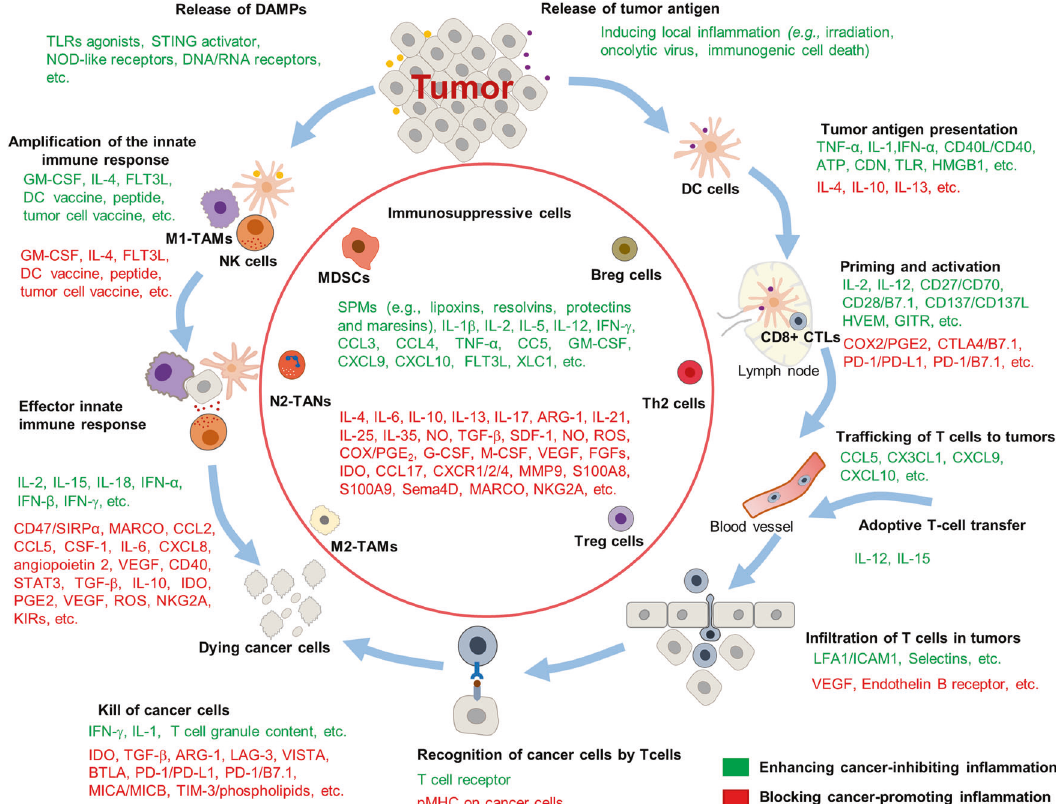
Fig. 4 Harnessing the in fl ammation in cancer therapy. Several promising strategies for regulation of cancer-related in fl ammation have been suggested to improve anti-tumor response. On the one hand, inducing in fl ammation and modulating immune cell activation would overcome T-cell exclusion, turning “ cold ” tumors into “ hot ” tumors, for instance, local in fl ammation induced by irradiation or oncolytic viruses can promote innate immunity by activating nucleic-acid-sensing cytosolic receptors (cGAS – STING or RLRs) and subsequent type I IFN response. Besides, promoting DC maturation by cGAS – STING, TLR agonist, DC vaccine, or injection of GM-CSF can induce an acute in fl ammatory response and priming of T lymphocytes, which facilitate tumor regression. On the other hand, inhibiting chronic in fl ammation by anti-in fl ammatory drugs (e.g., aspirin) or accelerating in fl ammation resolution by proresolving mediators (SPM, e.g., lipoxins, resolvins, protectins, and maresins) also display an overall survival bene fi t for anti-cancer therapy. Furthermore, limitations of the in fi ltration and function of immunosuppressive cells (e.g., MDSCs, Treg cells, Breg cells, and M2-TAMs) by blocking in fl ammatory pathways is another way to restore immune surveillance and promote anti-tumor immunity. Green represents factors that enhancing these